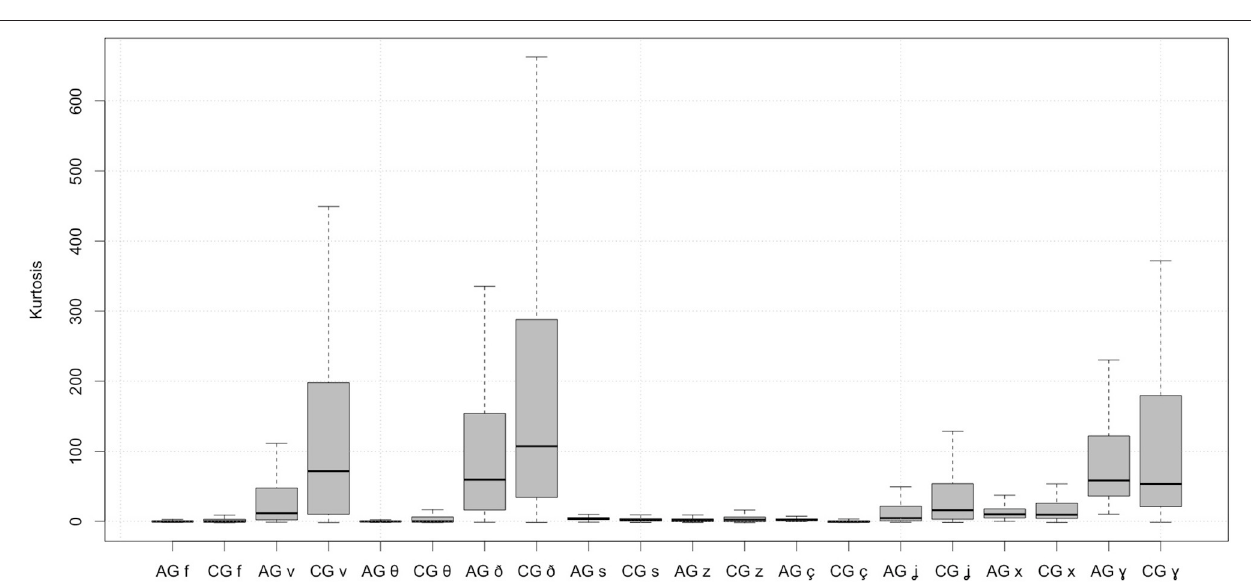
FIGURE 4 | Spectral kurtosis of Athenian Greek (AG) and Cypriot Greek (CG)